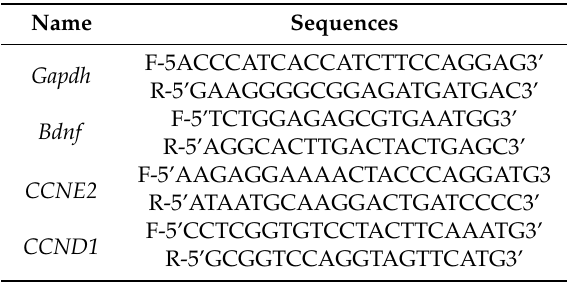
Table 1. Sequences of primers used in